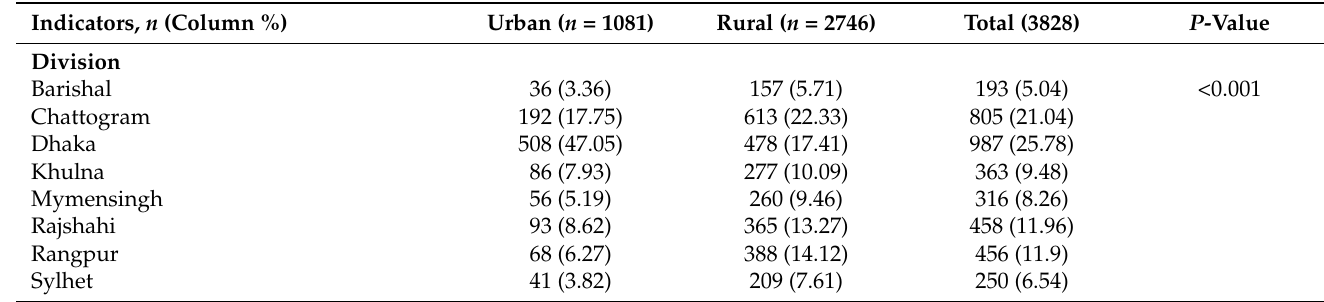
Table 1. Background characteristics of the study population ( n =